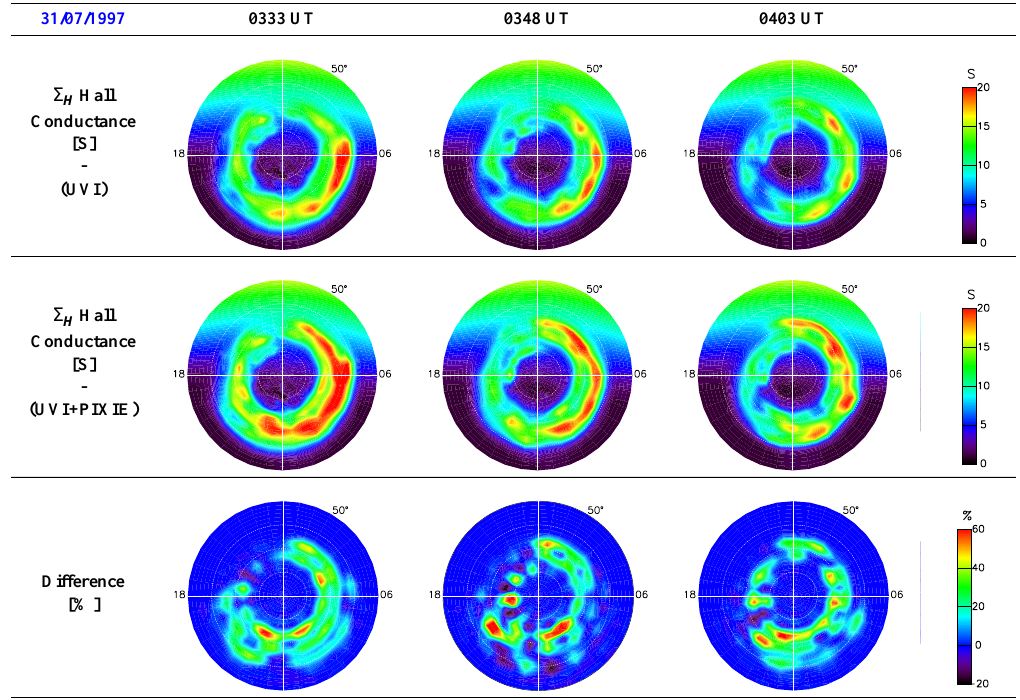
Fig. 9. Polar plots of the Hall conductance derived without (upper row) and with (middle row) PIXIE data between 03:30 and 04:05 UT on 31 July 1997. The differences in percent when including the PIXIE data are presented in the bottom row.